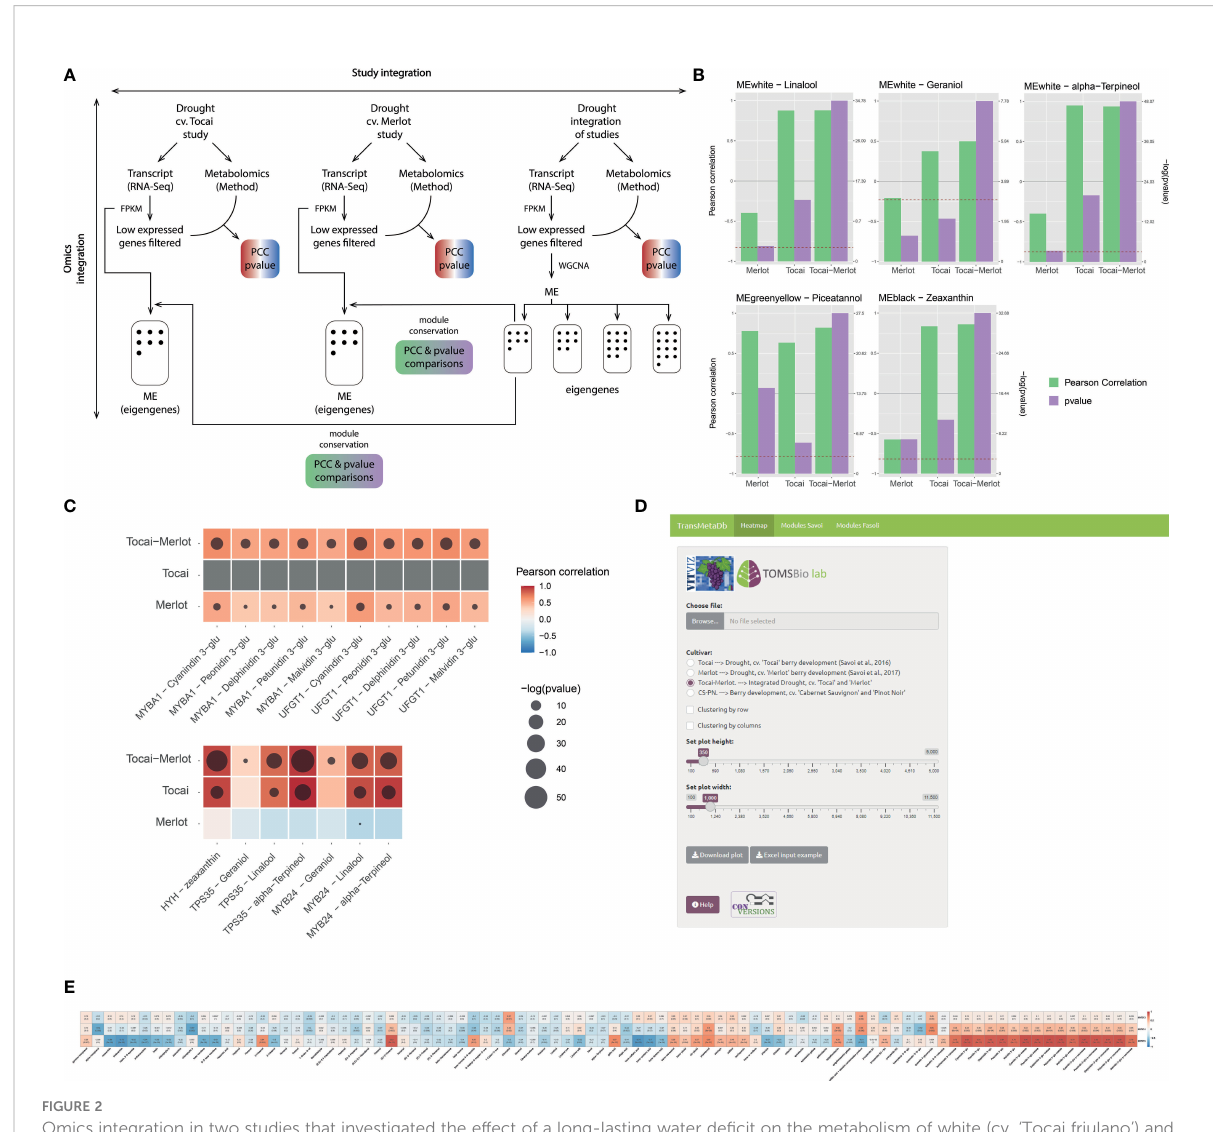
FIGURE 2 Omics integration in two studies that investigated the effect of a long-lasting water de fi cit on the metabolism of white (cv. ‘ Tocai friulano ’ ) and red (cv. ‘ Merlot ’ ) cultivars during berry development and ripening (Savoi et al., 2016; 2017). (A) Methods scheme of the analyses performed for each of the independent studies and the combination of them (i.e., study integration or meta-analysis). Genes with low expression are fi ltered- out before WGCNA analysis. (B, C) Results obtained from the analyses depicted in (A) , where (B) Improvement of statistical signi fi cance and/or correlation between genes and metabolites for the combination of both studies. P-value representation is only shown when the value exceeds the 0.05 threshold. (C) Improvement of statistical signi fi cance and/or correlation between gene modules and metabolites for the combination of both studies. A − log 10( p-value) scale is provided where a higher value represents a greater statistical signi fi cance. The red dashed line depicts − log 10( p-value) corresponding to a 0.05 threshold. (D) Visual interface of the TransMetaDb App, found at the Vitis Visualization (VitViz) platform (https://tomsbiolab.com/vitviz). The resulting example heatmap is shown in (E)